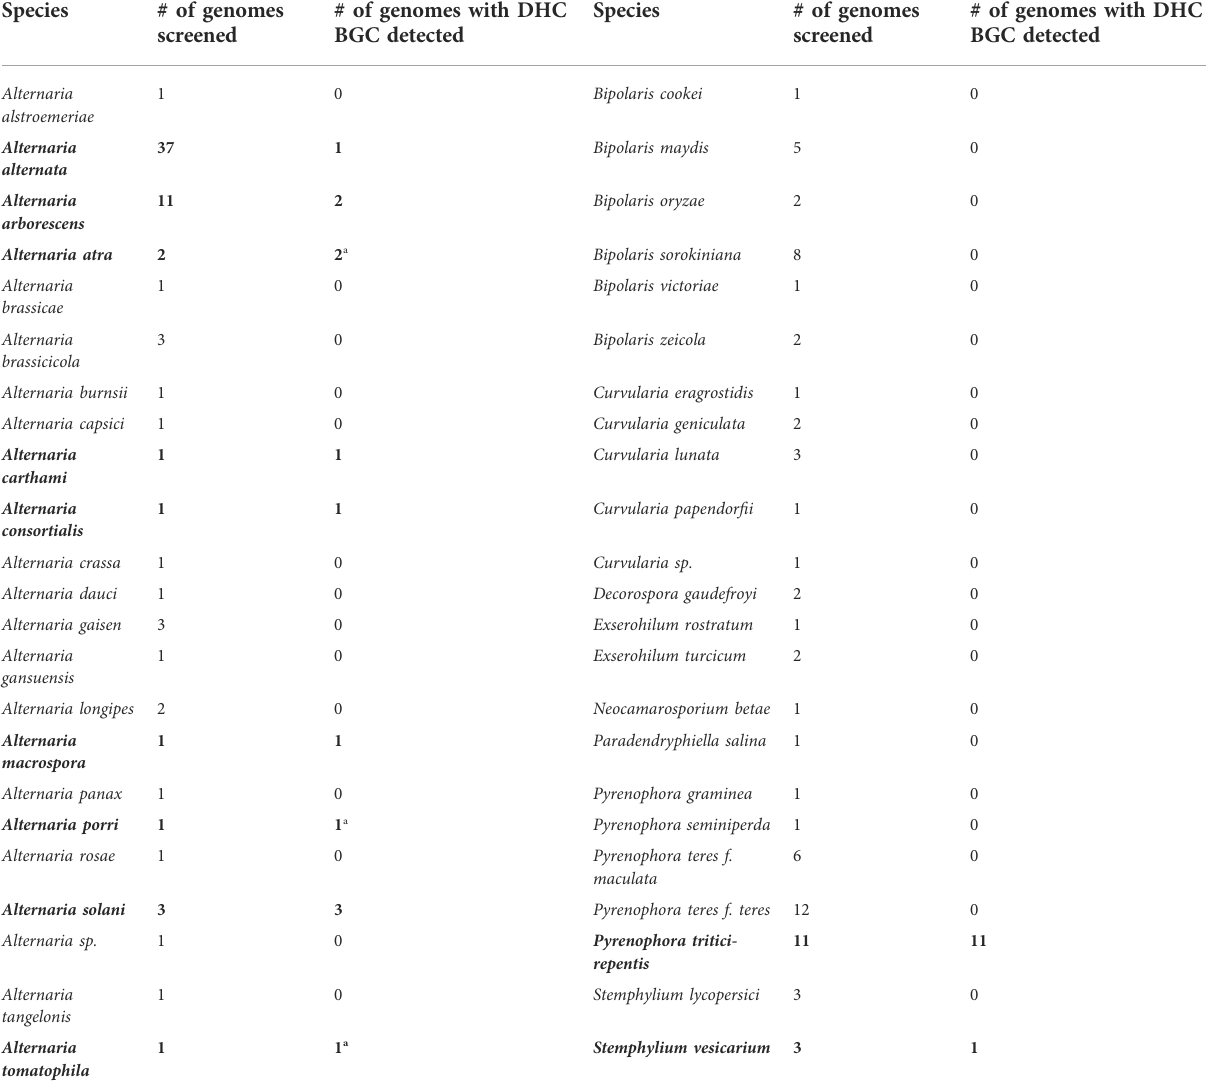
TABLE 4 BLASTn screening results for the dehydrocurvularin (DHC) BGC for the Pleosporaceae. Species with homologous BGCs are in bold text. Species # of genomes screened